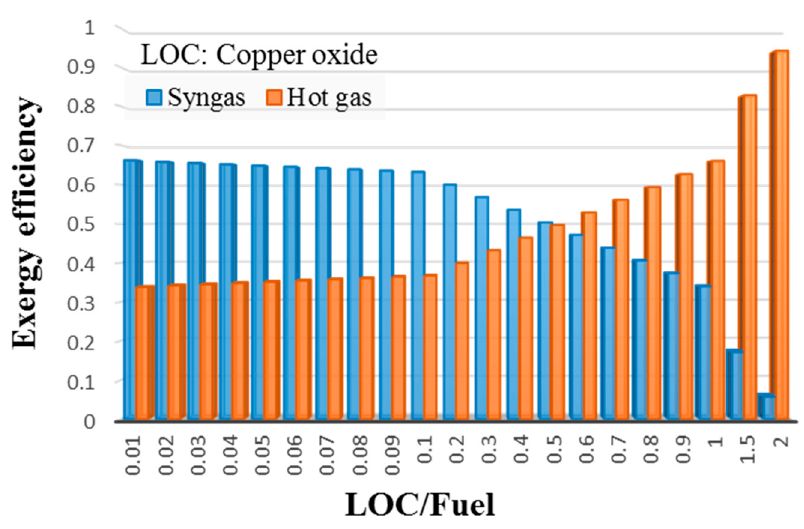
Figure 10. Exergy e ffi ciency for the LCLG working with liquid copper Figure 10. Exergy efficiency for the LCLG working with liquid copper oxide.